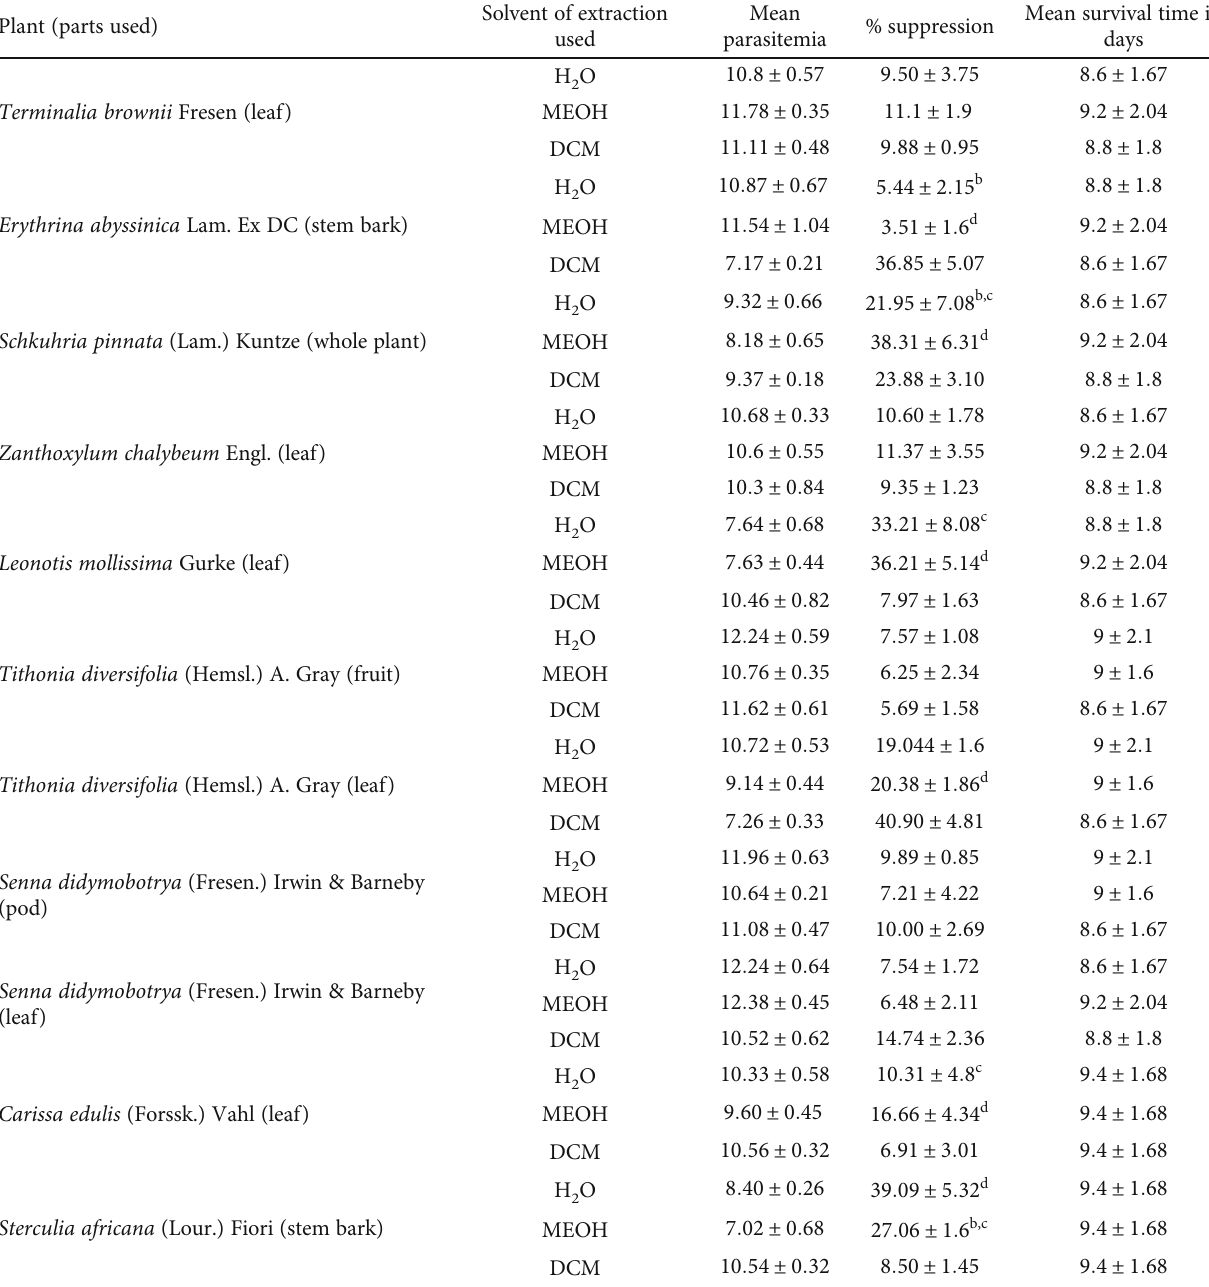
Table 3: Mean parasitemia, suppression, and survival time of mice in days ( ± SD) for extracts at 100 mg/kg. Solvent of Plant (parts used)